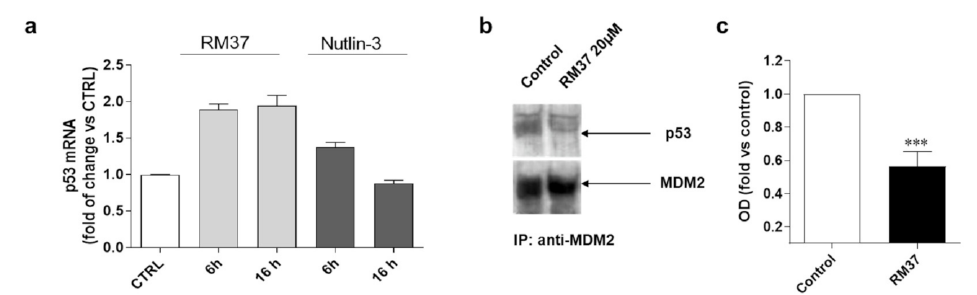
Figure 6. Degree of interaction of p53 with MDM2 in GBM cells. ( a ) U343MG cells were treated with 20 µ M RM37 for 6 or 16h. Relative quantification of p53 mRNA was performed by real-time RT-PCR. Data are expressed as fold of change versus control cells, set to 1. ( b , c ) U343MG cells were treated with 20 µ M RM37 for 8h. After incubation, immunoprecipitation assay was performed. Representative immunoblot was shown. ( b ) Full screen of Western blot assay was provided in separate file. Data are expressed as fold of optical density (OD) of immunoreactive band relative to that of control, set to 1, and are mean values ± SEM of three different experiments. *** p < 0.01 versus